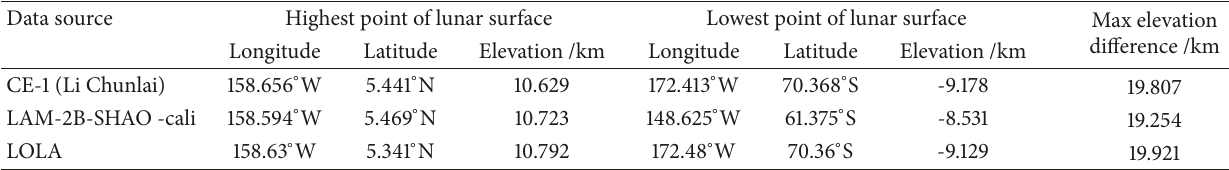
Table 3: The highest and lowest points from different lunar DEMs.